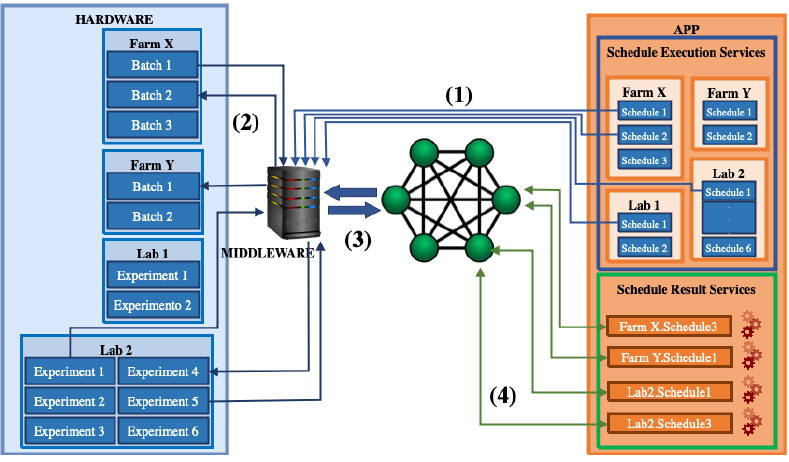
Figure 2. IoTCocoa architecture (module view).